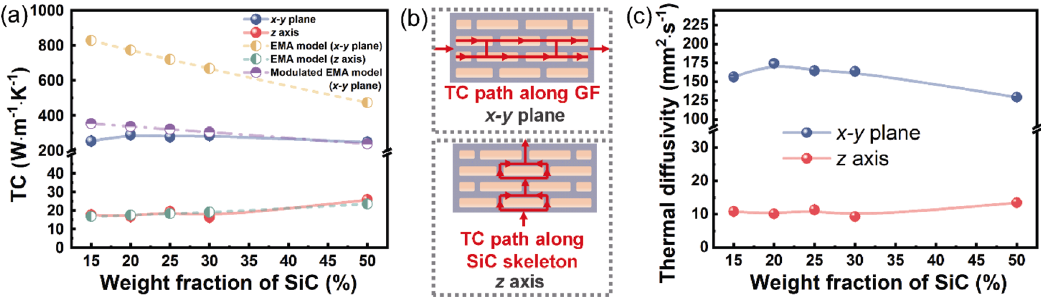
Fig. 8 (a) TC, (b) conductive paths, and (c) thermal diffusivity of the composites in two principal